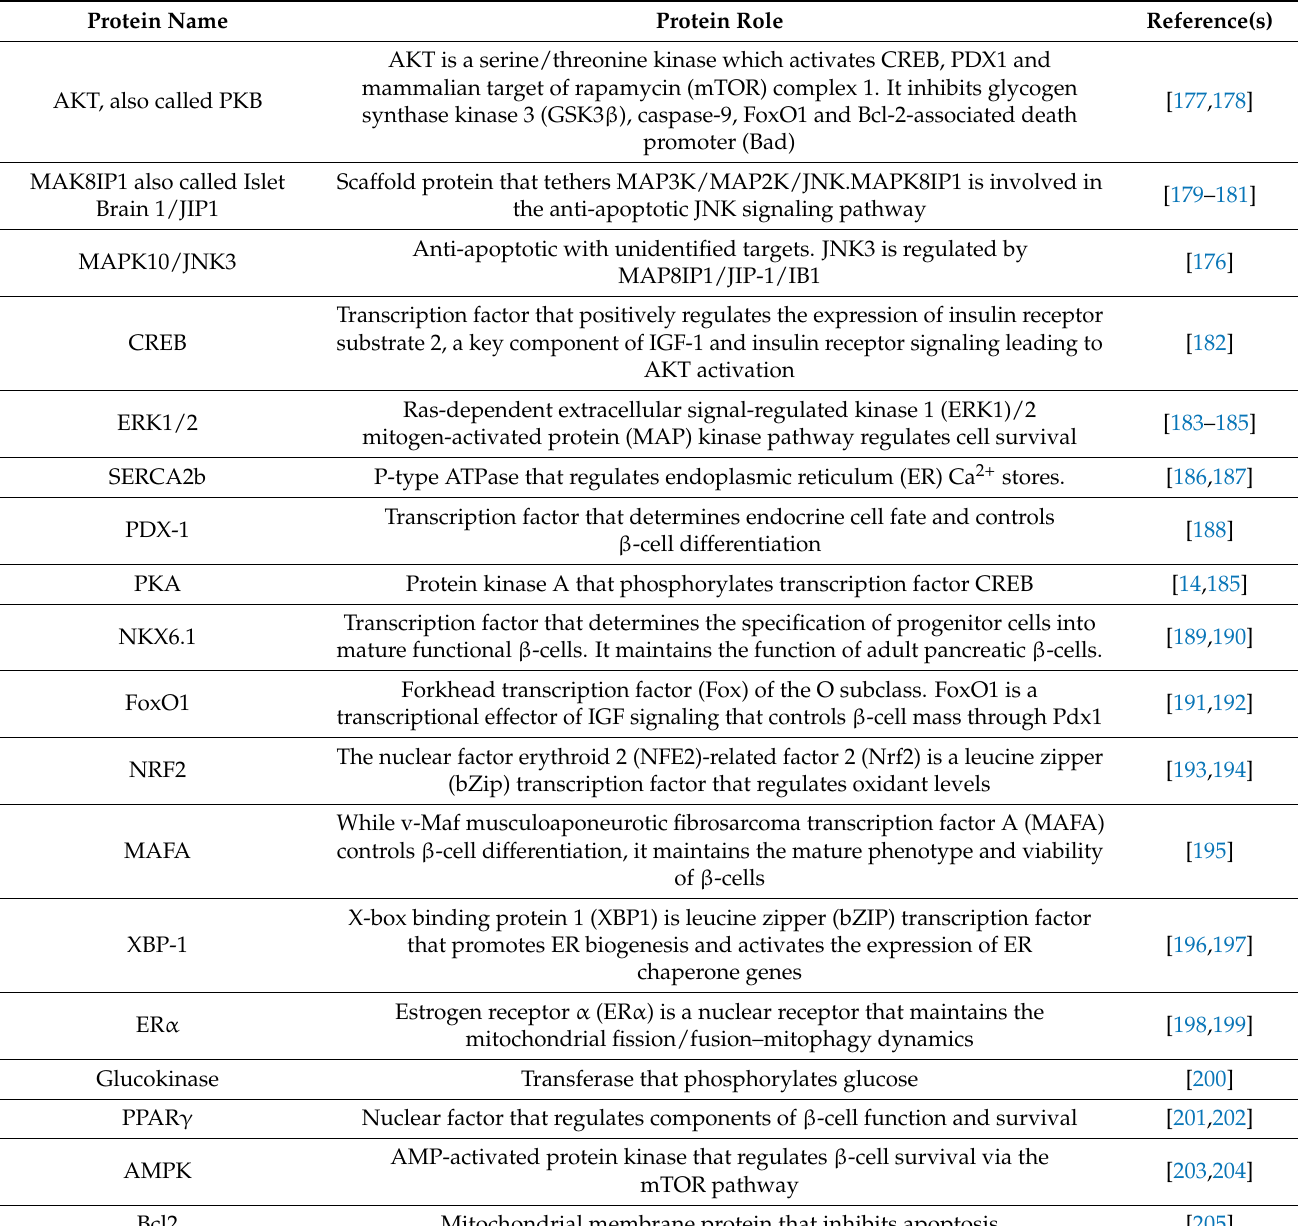
Table 6. β -cell survival proteins induced by